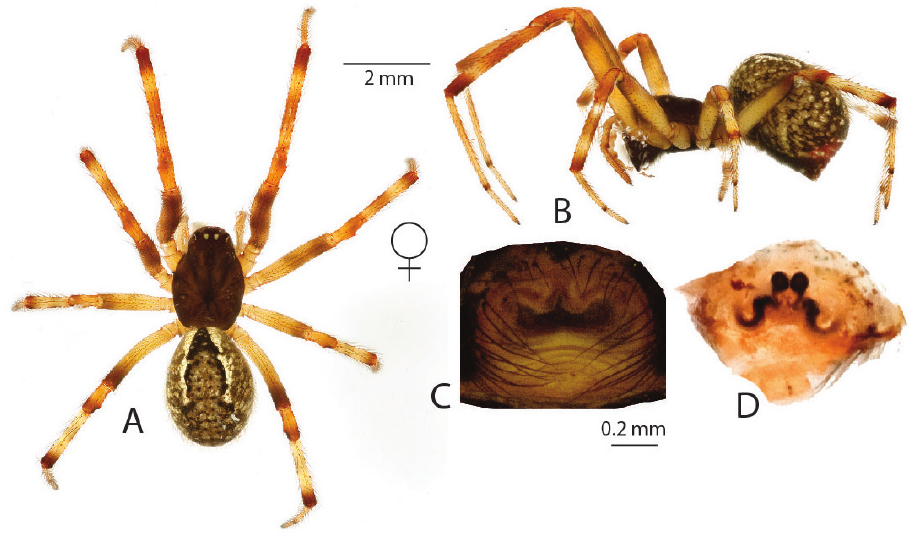
Figure 9. Anelosimus lamarcki : A–B female dorsal and lateral views C epigynum ventral view D epigynum cleared